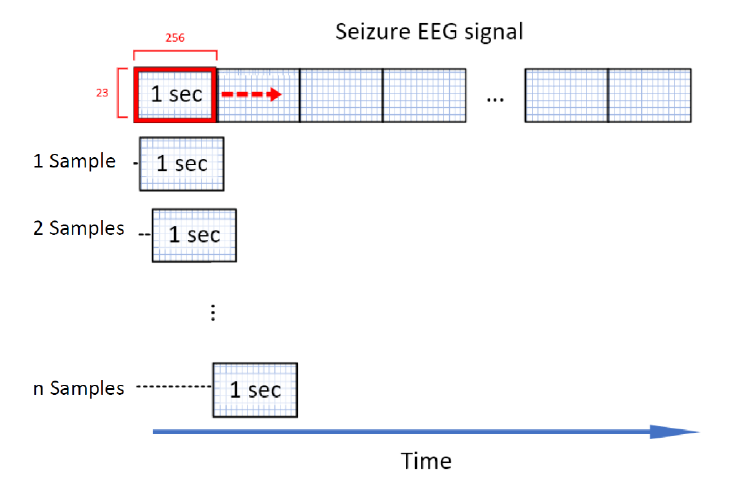
Figure 1. Sliding window technique [27]: A window with a length of 256 samples/1 s is sliding over seizure data with a step size of S = 1 sample to generate extra seizures for a balanced training